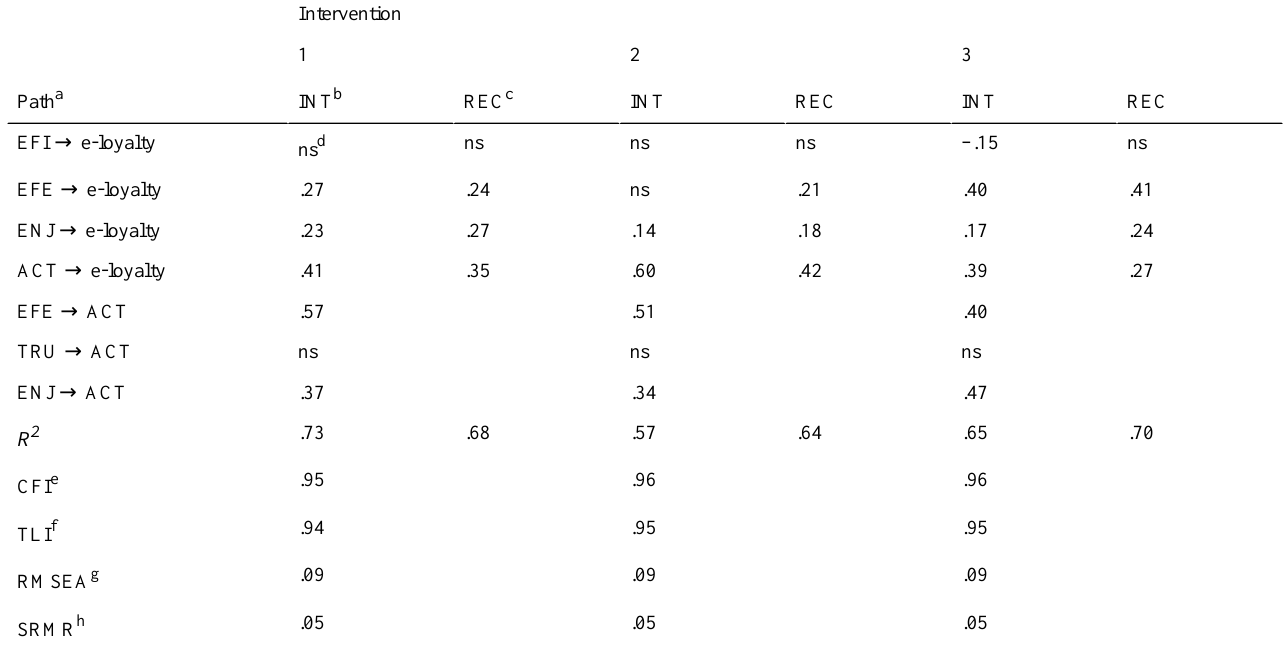
Table 5. Results of extended model (figures are standardized betas of paths within the model)